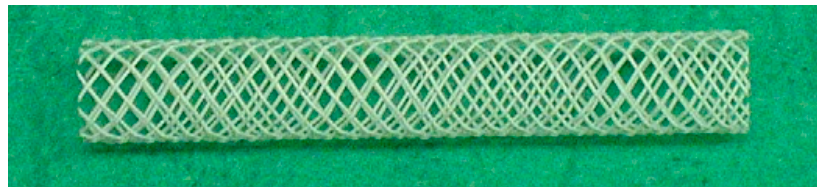
Figure 9. Self-expanding PLA BaSO 4 stent (fully expanded), reproduced from [140], with permission from Elsevier, 2019.